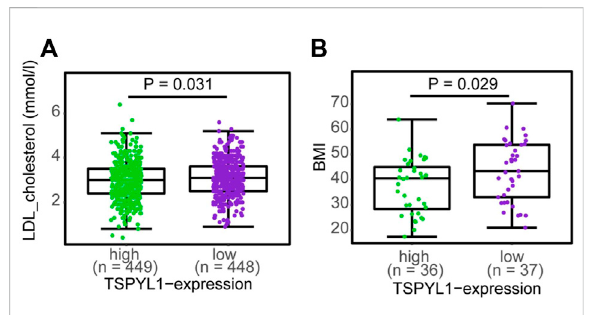
trials. (A) LDL-cholesterol levels subgrouped by median TSPYL1 expression, using hepatic expression array data for the